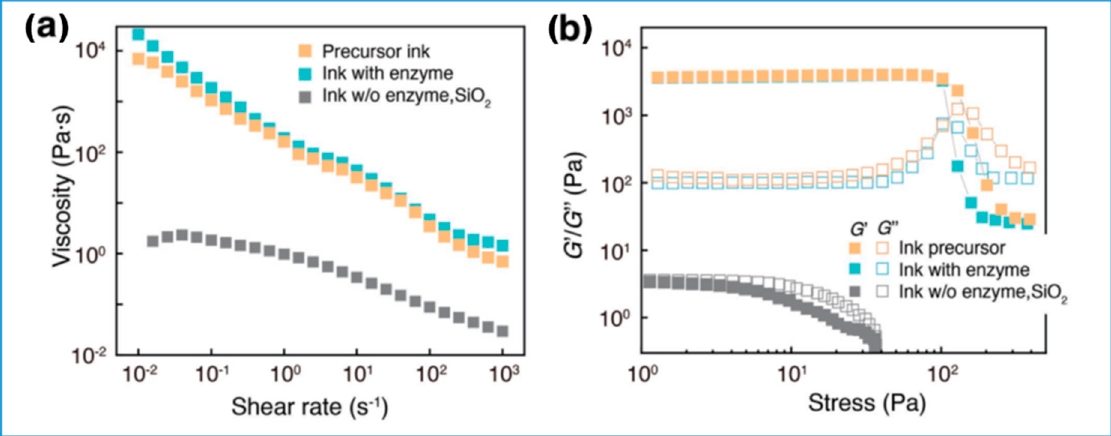
Figure 5. Evaluation of printability of hydrogel inks: ( a ) apparent viscosity vs. shear rate and ( b ) storage moduli (G ′ ) and loss moduli (G ″ ) vs. shear stress measured at oscillatory frequency of 1 Hz (reproduced with permission from Ref. [74]).